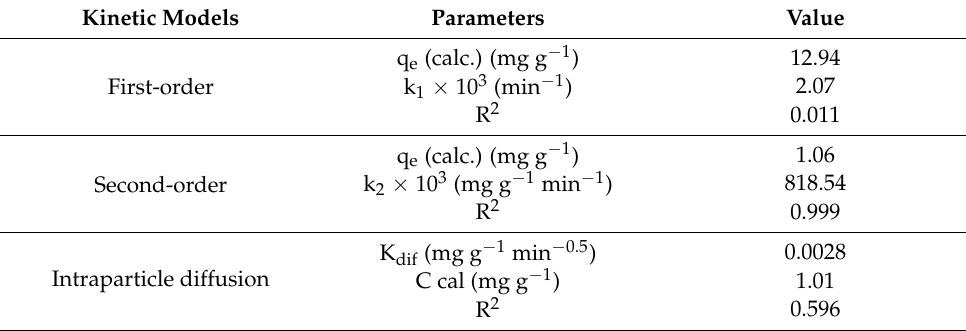
Table 5. Parameters of the different adsorption kinetic models.